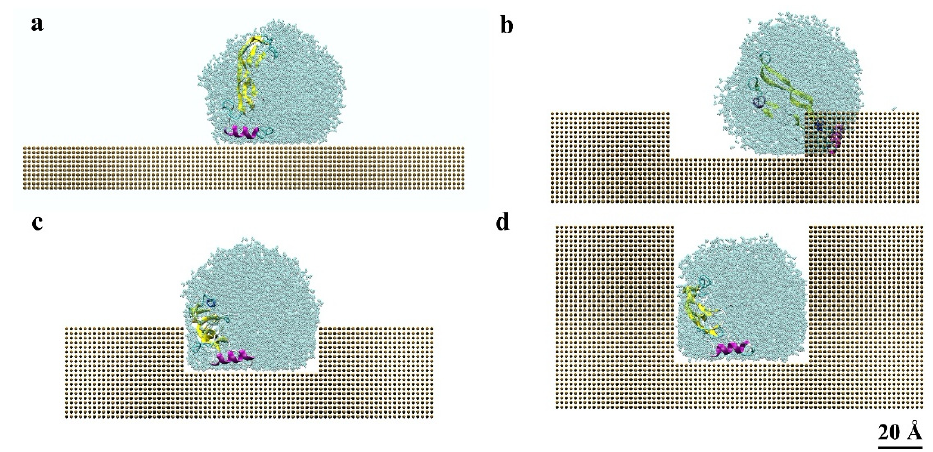
Figure 7. Side view of the protein trajectory at 20 ns: ( a ) flat (FLT); ( b ) pillars (PLR); ( c ) shallow linear grating (SLG); ( d ) deep linear grating (DLG).